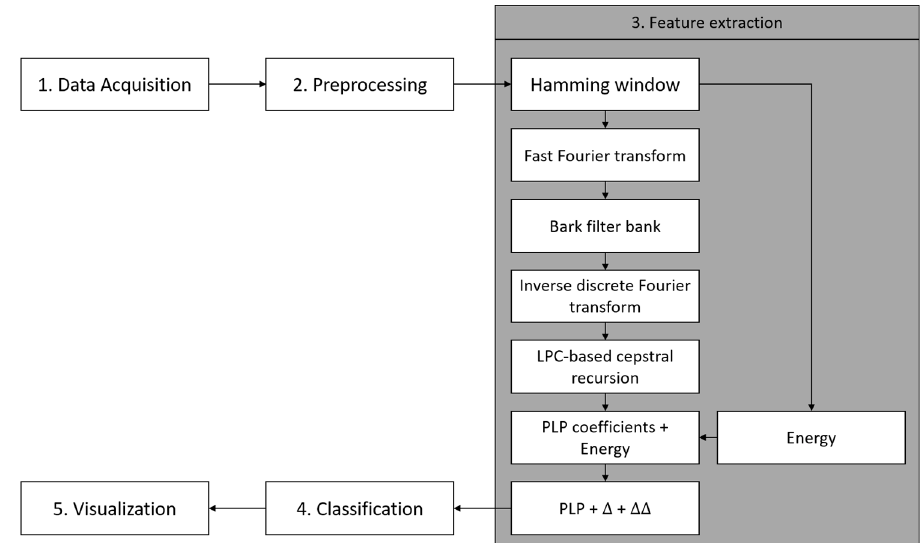
Figure 19. A proposed step for PLP feature extraction.